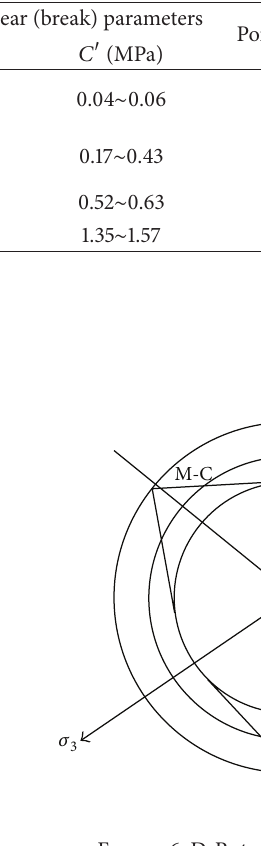
Figure 6: D-P strength curve in the 𝜋